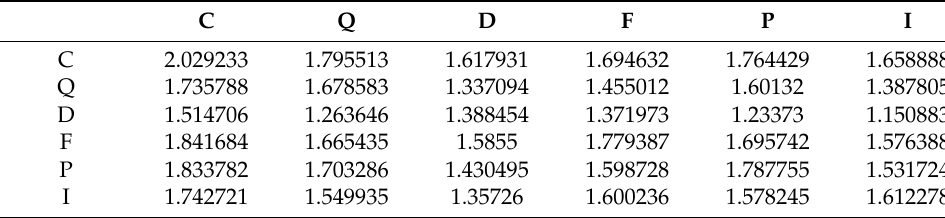
Table 5. The total relation matrix.